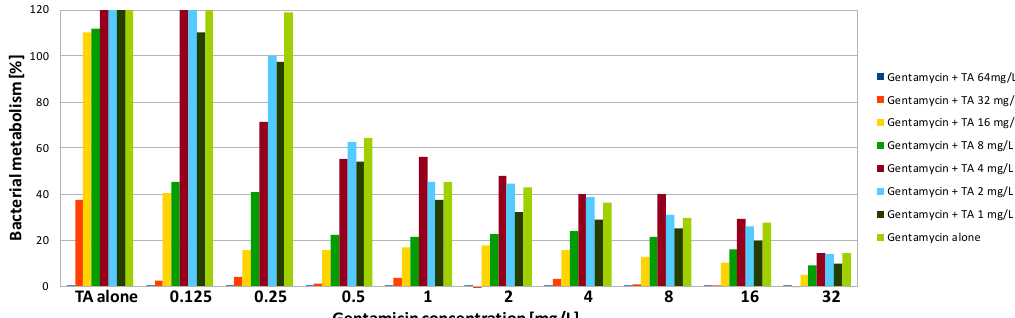
Figure 3. Activity of gentamicin in combination with temporin A (TA) against SA biofilm. Results presented as percentage of metabolic activity in comparison to positive (100%) and negative (0%) controls; RSD ≤